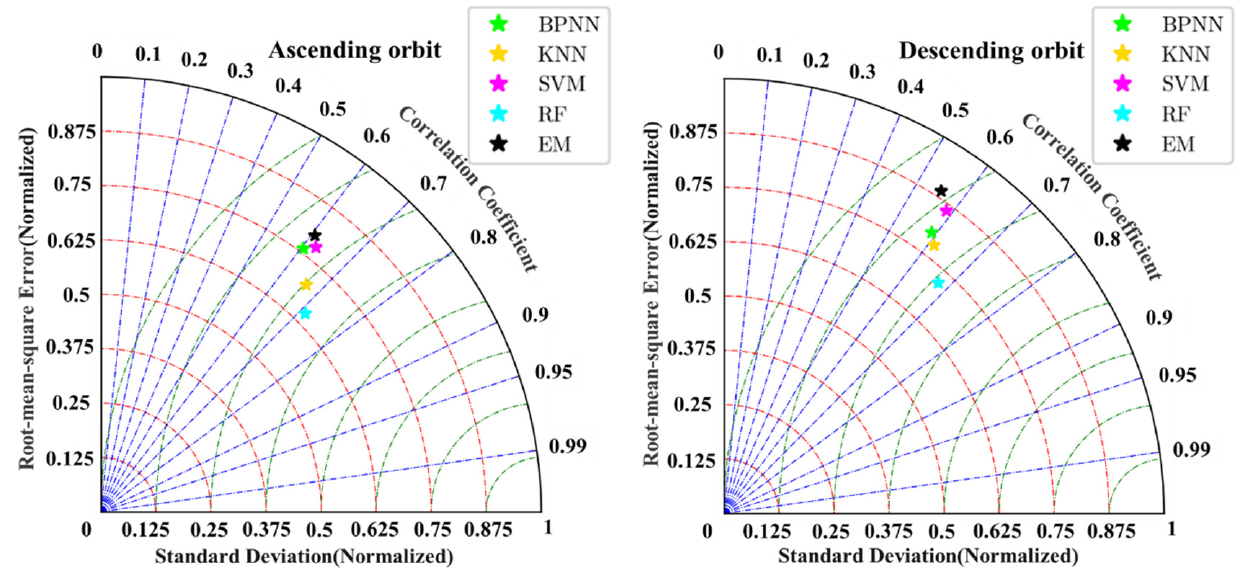
Figure 9. Comparison of soil moisture of different models for ascending and descending orbits.